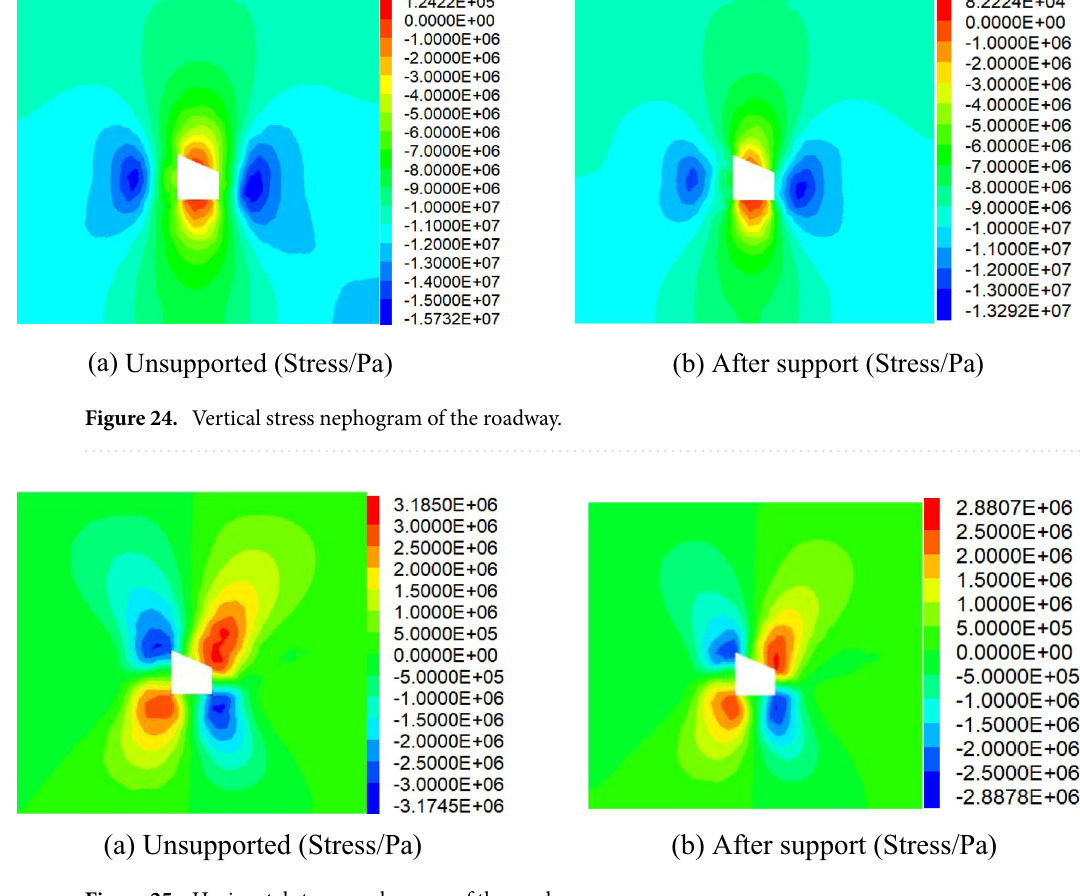
Figure 25. Horizontal stress nephogram of the roadway.